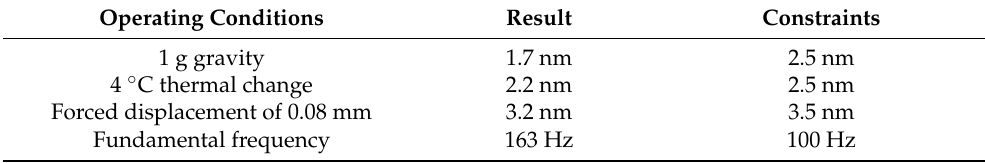
Figure 4. The optimal axial installation position of flexible support. 3. Effect of Blank Error on Mirror Accuracy It is well known that when the flexure’s rotation center is located in the neutral plane of the mirror, the gravity surface shape of the mirror assembly is optimal. When the flex- ure deviates from the optimal axial installation position, the surface shape will degener- ate. During the simulation analysis, the RMS value at each position is obtained by chang- ing the axial assembly position of the flexible support, and the sensitivity relationship